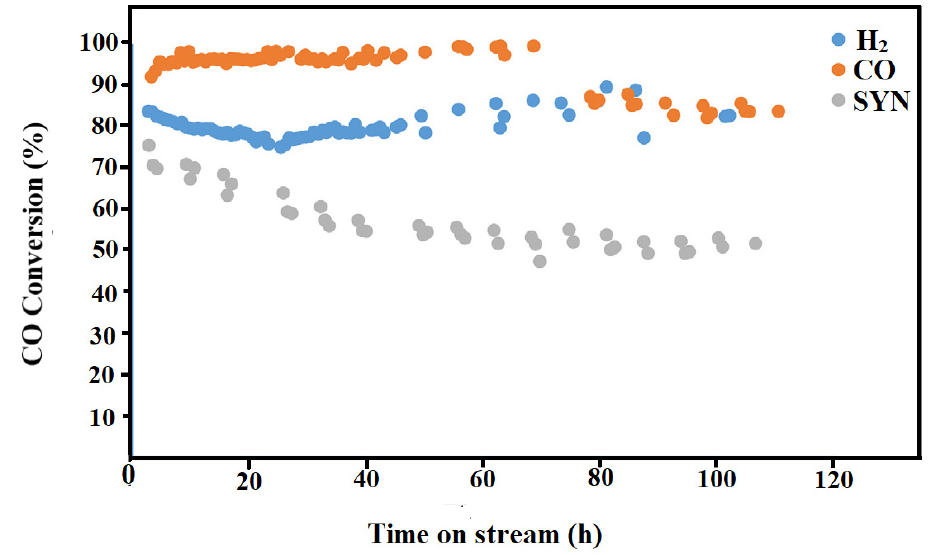
Figure 4. CO conversions of raw iron ore under varying reducing agents [2]. Reproduced with permission from Elsevier.